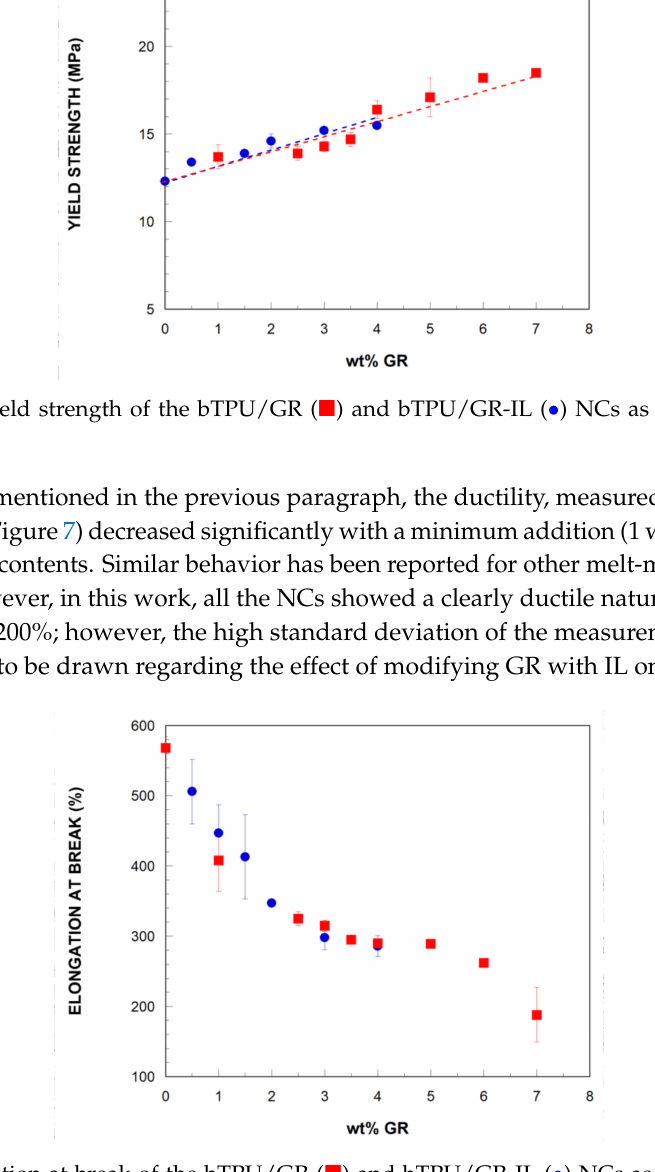
Figure 7. Elongation at break of the bTPU/GR ( (cid:4) ) and bTPU/GR-IL ( • ) NCs as a function of the GR